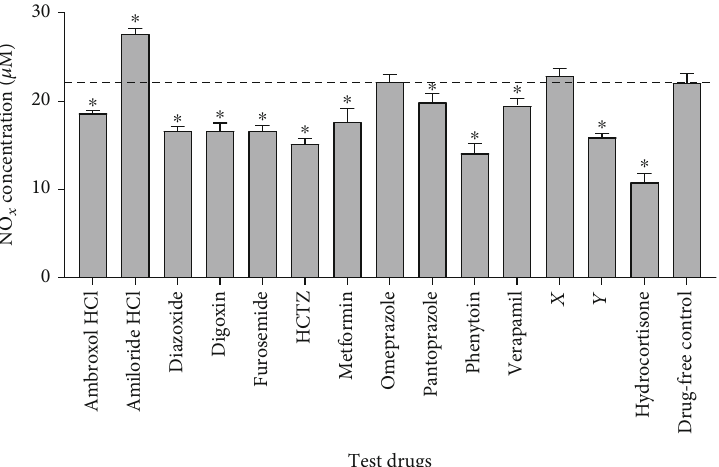
Figure 1: E ff ects of ion transport modulators on the production of nitrites and nitrates by THP-1-derived macrophages. Macrophages were stimulated with ethanol-inactivated M. bovis BCG in the presence or absence of the test drugs over 24 hours. Nitric oxide production was then assessed by quantifying NO x levels in the supernatant using the Griess assay. Nitric oxide production was compared between the di ff erent cultures using one-way analysis of variance (ANOVA) followed by Dunnett ’ s post hoc test. Data are presented as mean + SD of six replicates pooled from two independent experiments. Dashed line indicates nitric oxide production in drug-free controls. ∗ indicates p < 0 : 05 vs. drug-free controls. HCTZ: